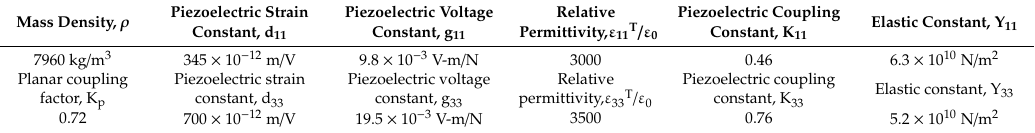
Table 2. Properties of the piezoceramic transducers (Model: ped20t10s-md3 (produced by ELECERAM TECHNOLOGY CO.,